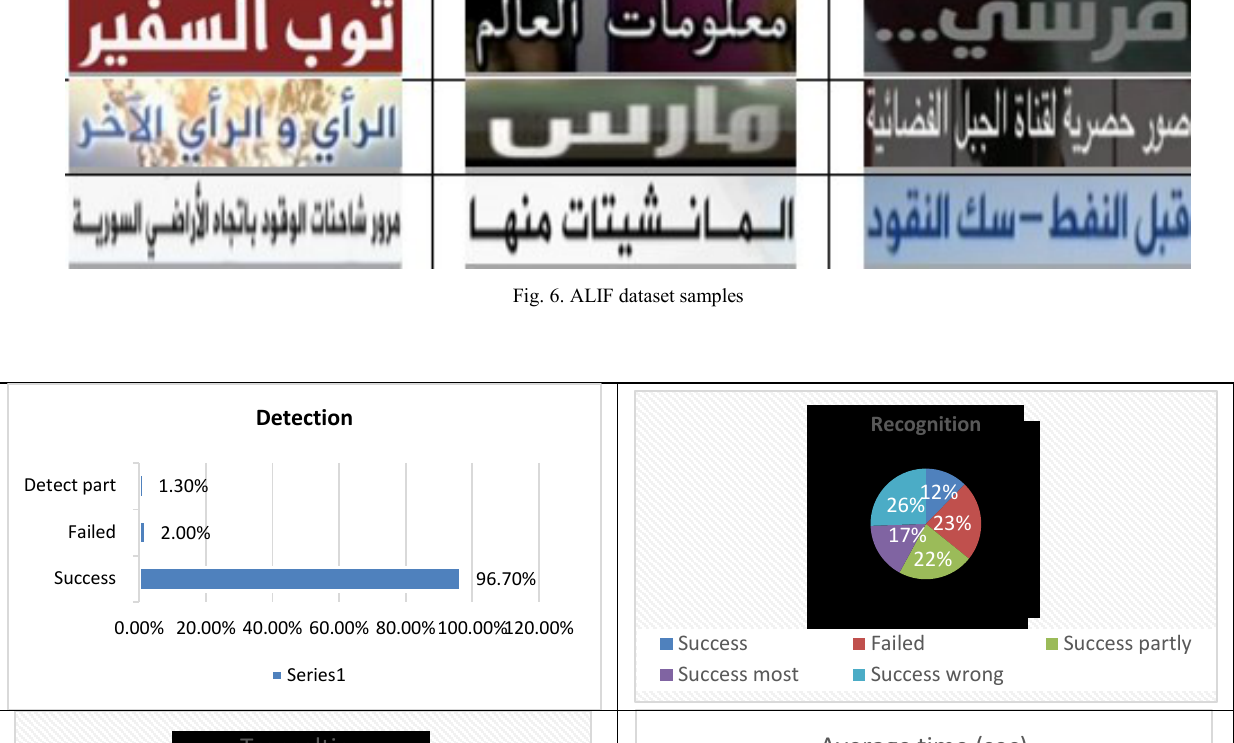
Table 4. Number of images detected, recognized and translated in ALIF dataset.